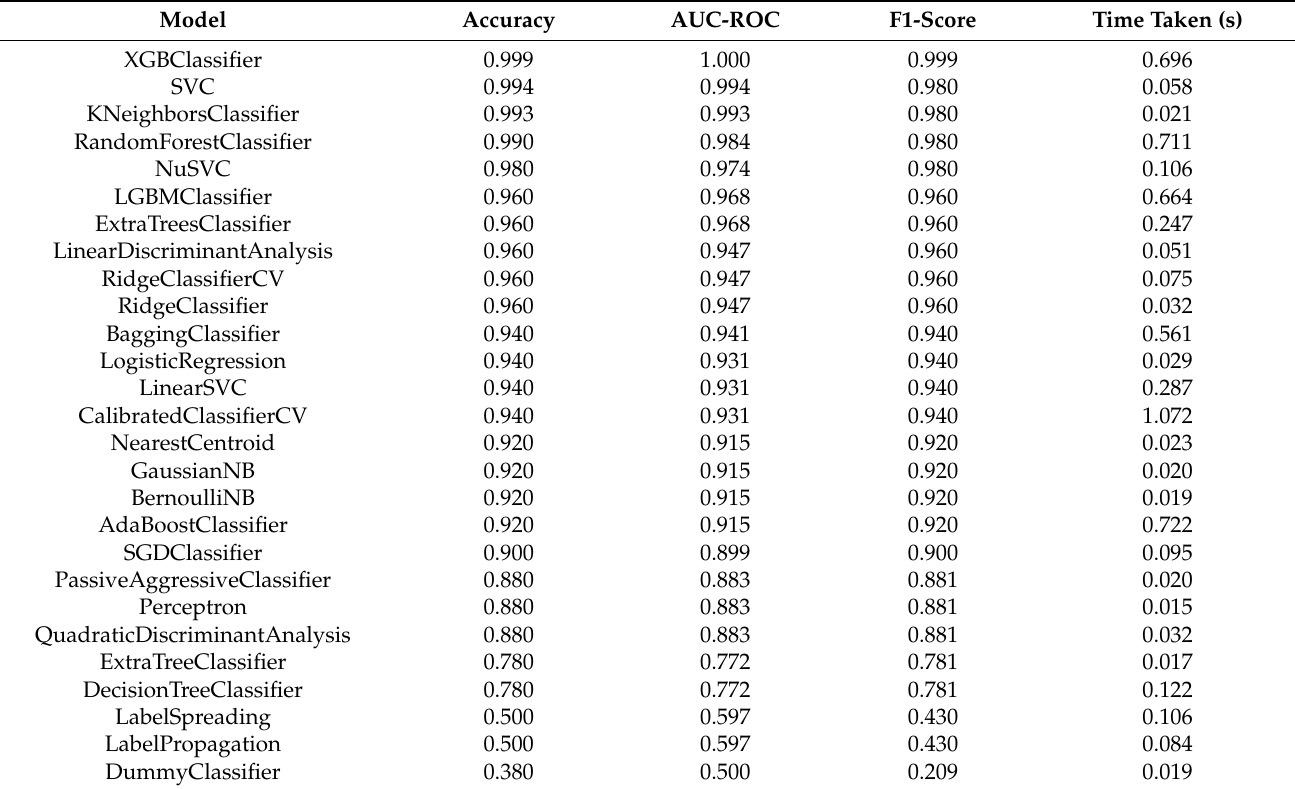
Table 2. Evaluation of 27 Classifiers on Extended Dataset.